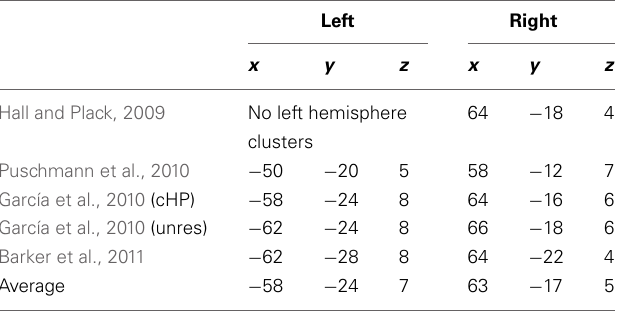
Table 1 | Location (MNI coordinates) of pitch-related responses identified by previous fMRI studies using various pitch-evoking stimuli.